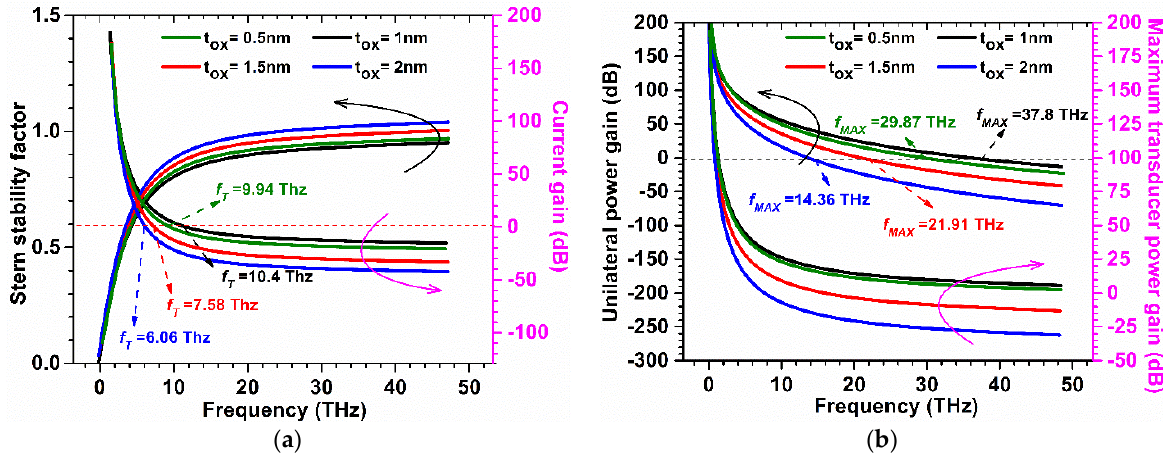
Figure 16. ( a ) SS and Current Gain at various oxide thicknesses of GaN-SOI-FinFET. ( b ) Unilateral Power Gain and G MT at various oxide thicknesses of GaN-SOI-FinFET.